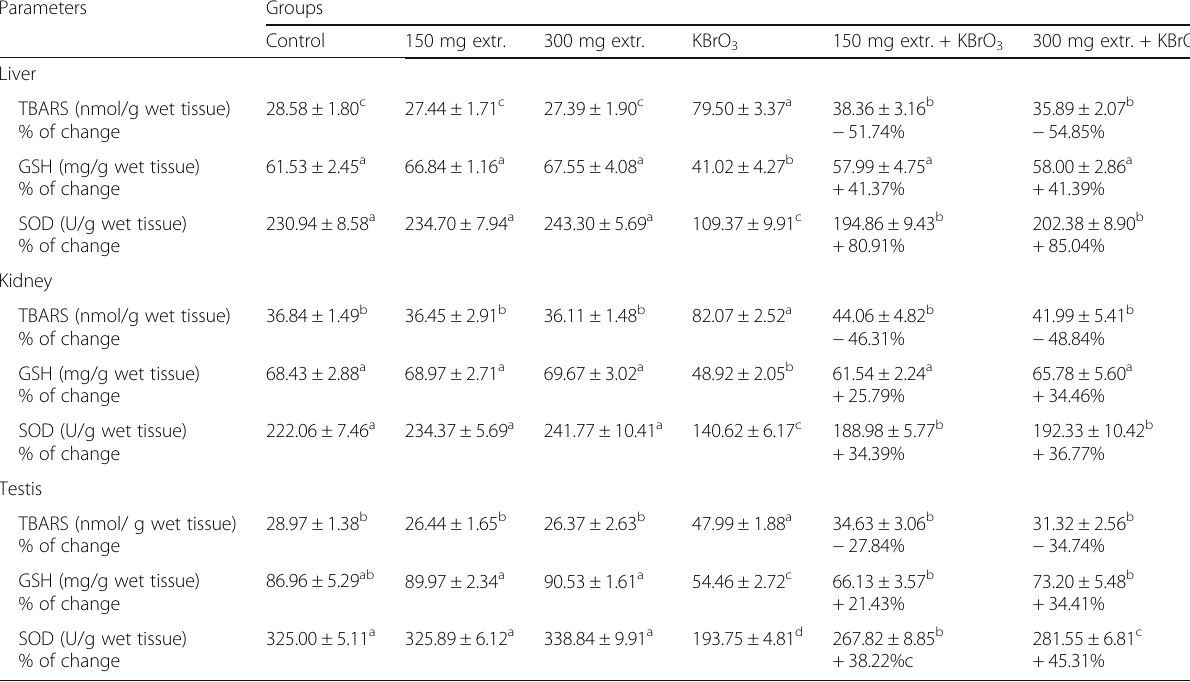
Table 1 Effect of potassium bromate and/or strawberry leaves extract on TBARS, GSH, and SOD in hepatic, renal, and testicular tissues of different rat groups